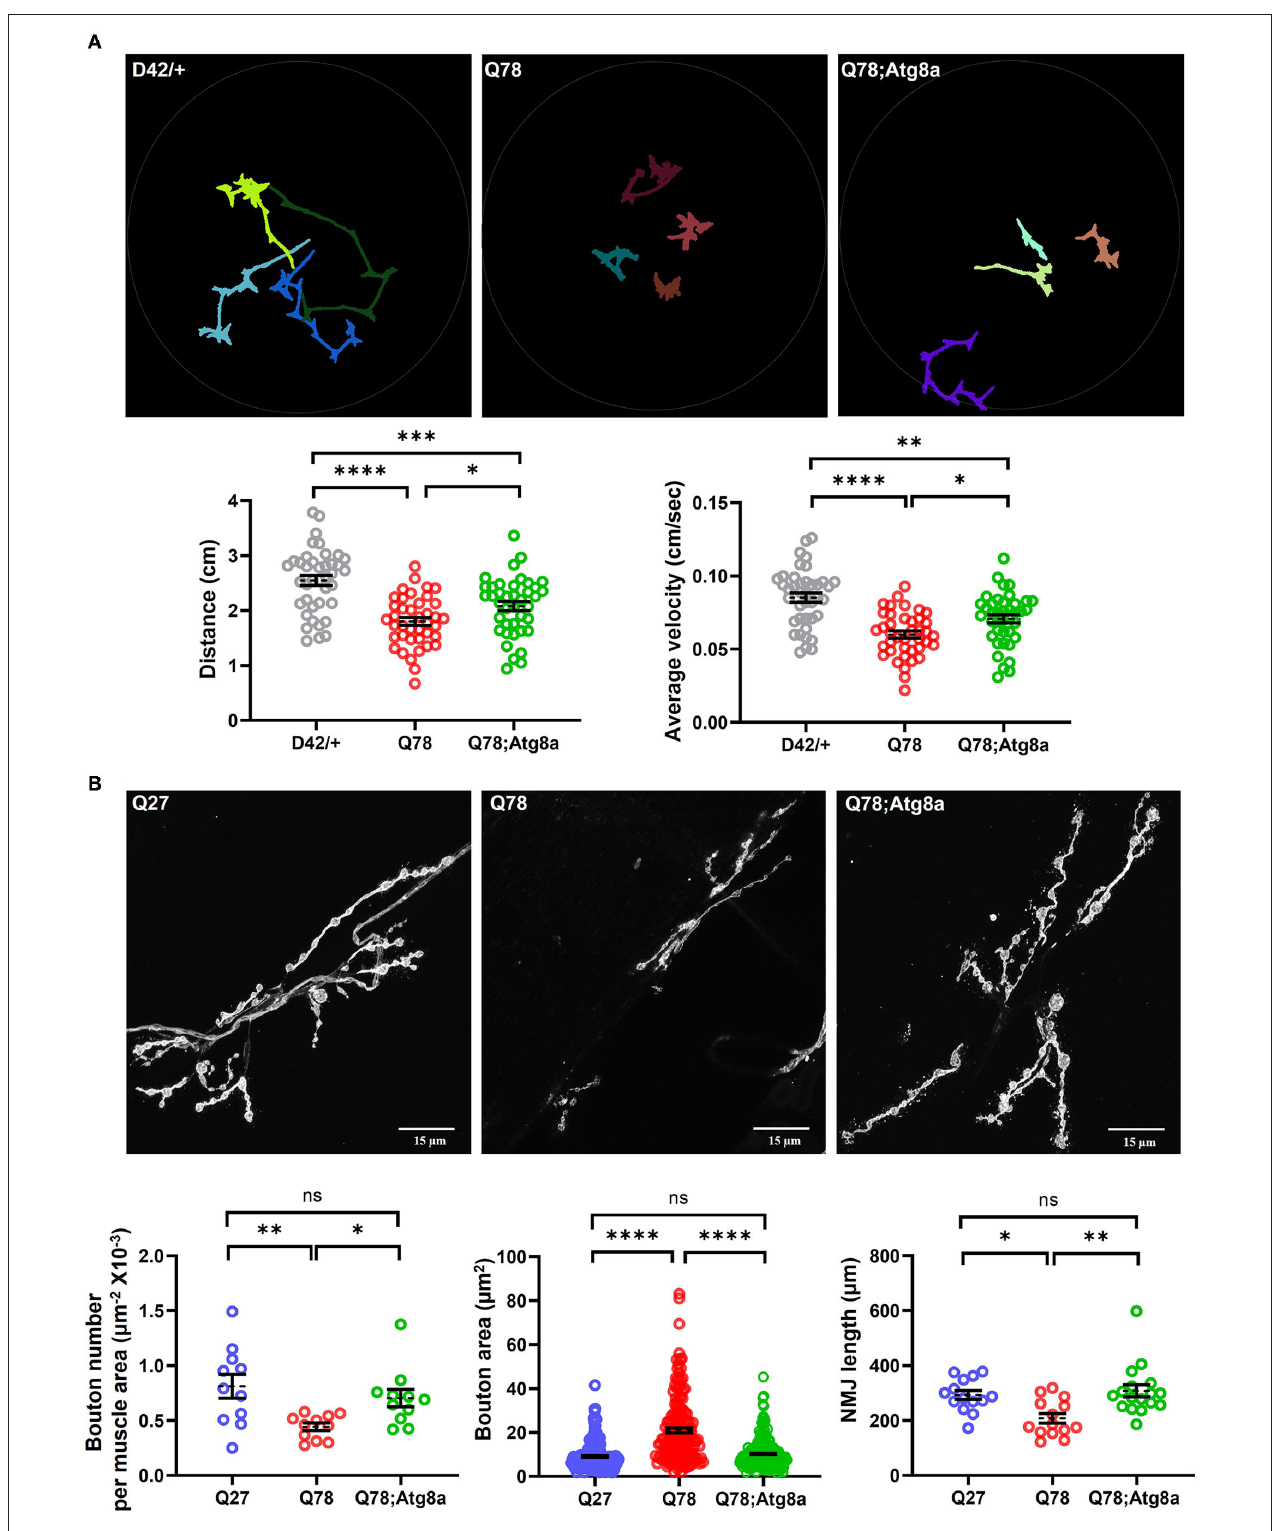
FIGURE 5 | The behavioral and morphological defects in larval glutamatergic synapses are rescued upon Atg8a overexpression. (A) Path diagrams for indicated larvae monitored in 1% charcoal agar plates and quantification of total distance traversed and average velocity of the driver-only control larvae (D42/ + ) vs. pathogenic Q78 and rescue Q78; Atg8a larvae. n = 40 larvae; one-way ANOVA; post-hoc Tukey’s multiple comparison test; * p < 0.05; ** p < 0.01; *** p < 0.001; **** p < 0.0001;